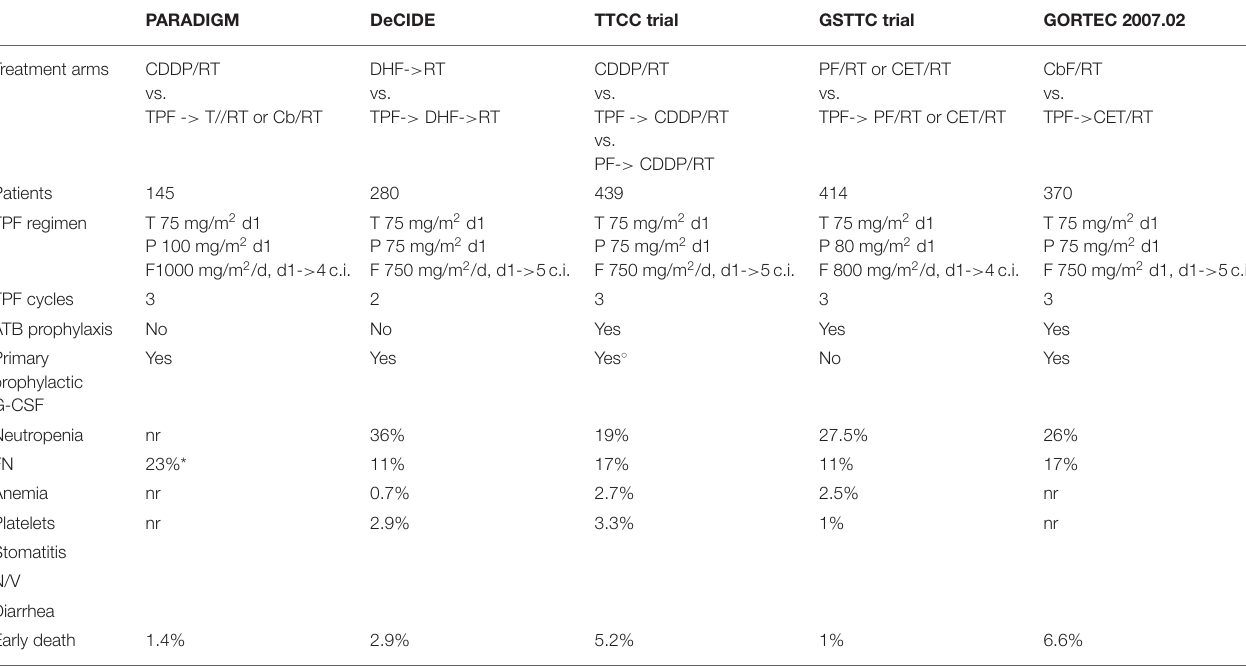
TABLE 2 | G > 3 Adverse Events of induction TPF in the Phase III trials comparing concomitant treatment vs. sequential treatment.